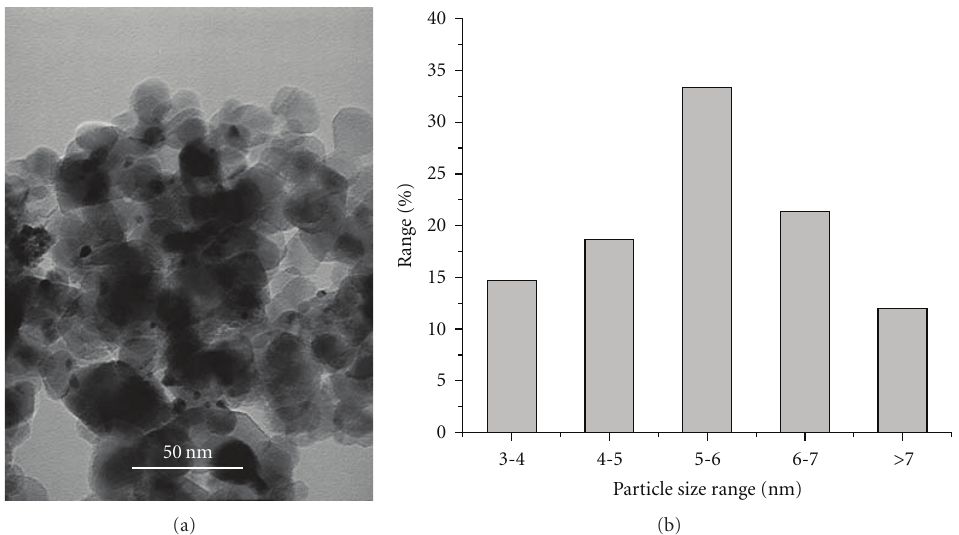
Figure 7: Selected transmission electron micrograph and distribution of platinum particle sizes of Pt/TiO 2 photocatalyst.